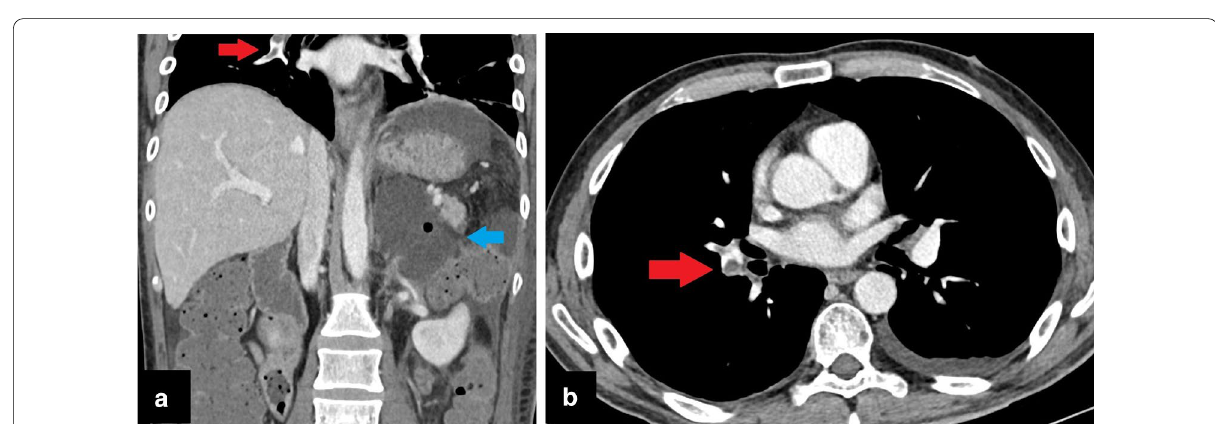
Fig. 12 Location-related (type 9) error with under-reading. In a 28-year-old male patient with adrenalectomy, abdominal CECT was performed for evaluation of postoperative complications. Collection in the surgical area (blue arrow, a ) and postoperative changes were reported. Although filling defects in the right pulmonary artery were involved in upper CT slices, they could not be noticed due to their locations (red arrows, a , b ). As in this case, the marginal areas are prone to this type of error. There is also an accompanying under-reading error because the pulmonary emboli could be clearly seen and should have been